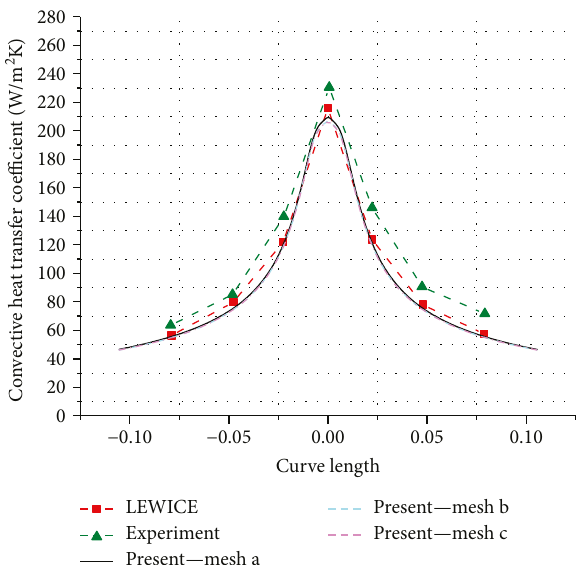
Figure 7: Comparison of droplet collection e ffi ciency.